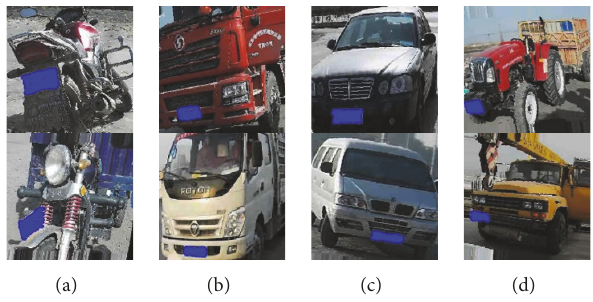
Figure 3: Sheared vehicle image examples for four categories. (a) Motorcycle; (b) transporter; (c) passenger; (d) others.